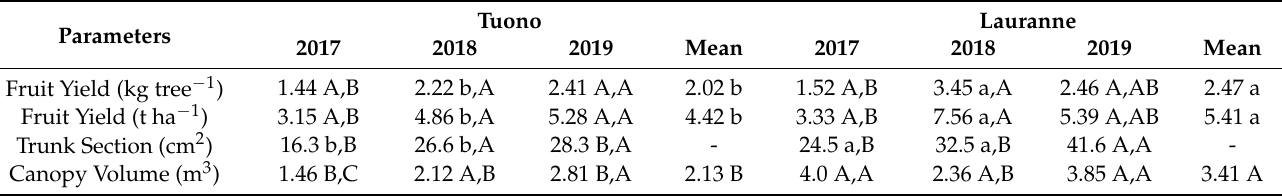
Table 1. In-shell almond yield, trunk section, and canopy volume of cultivars Tuono and Lauranne in three subsequent years (2017–2019). The first letters denote statistical differences between cultivars for each year; the second letters denote statistical differences among years for each cultivar. Lower case letters denote statistical differences at p = 0.05; capital letters denote statistical differences at p = 0.01. (SNK test).